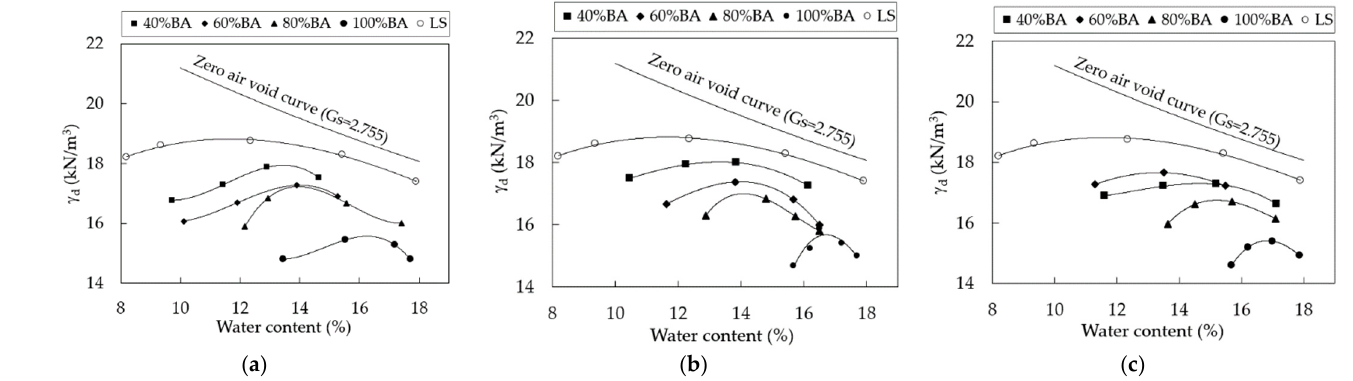
Figure 4. Compaction curves of the CSS specimens: ( a ) cement = 3%; ( b ) cement = 5%; ( c ) cement = 7%.